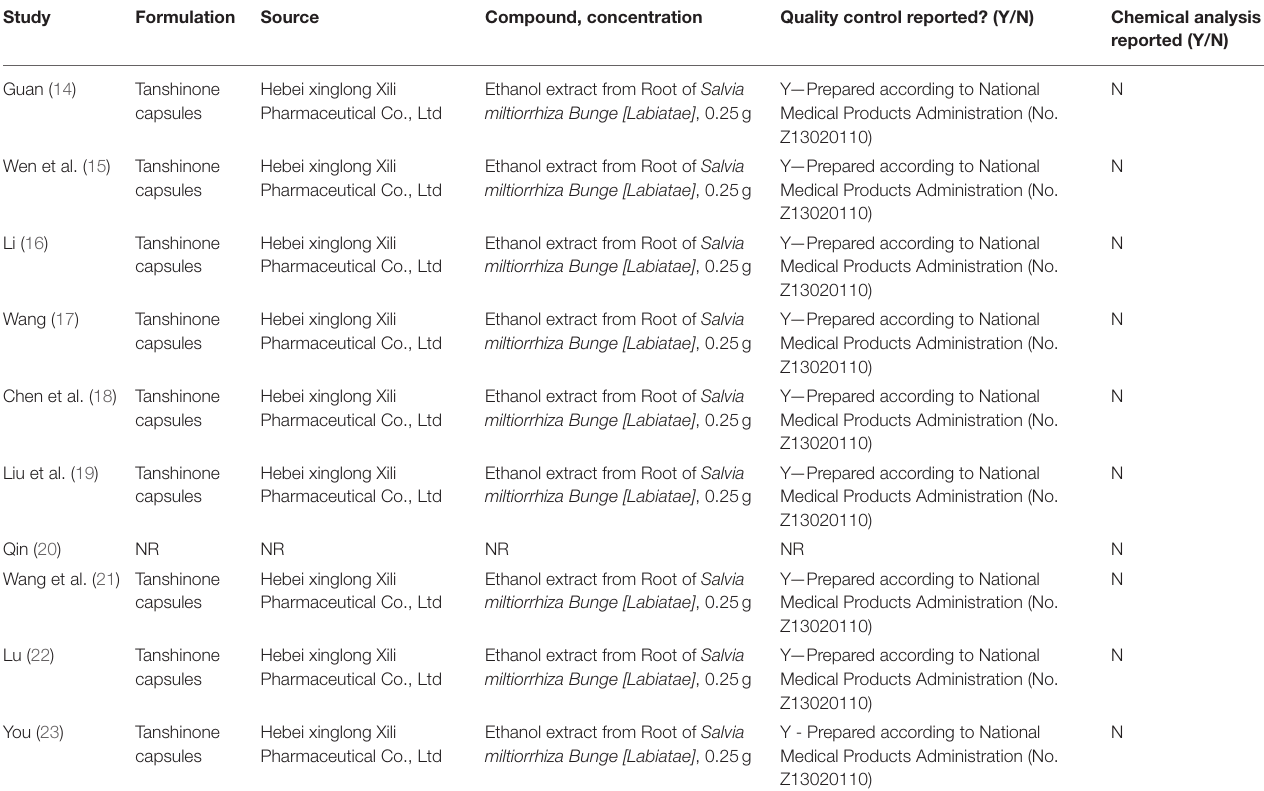
TABLE 2 | Quality control of Tanshinone